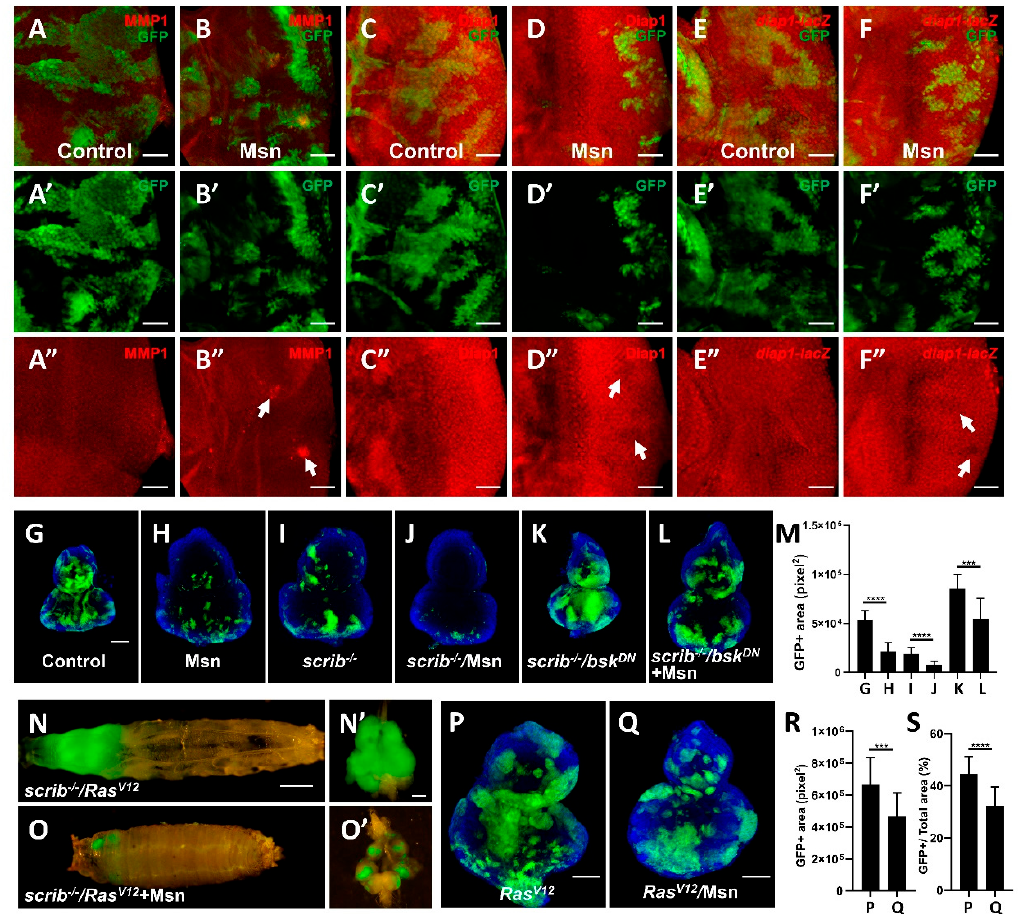
Figure 3. Msn positively regulates Hippo signaling. ( A – F, A’ – F’ and A” – F” ) Fluorescence micrographs of eye discs are shown. Compared with wild type ( A – A” , C – C” and E – E” ), Msn overexpression induces mild JNK activation ( B – B” ) and Hippo target gene downregulation ( D – D” and F – F” ). ( G – L ) Fluorescence micrographs of GFP-labeled clones of eye discs are shown. Msn overexpression decreases wild type clone size ( G and H ), scribble ( scrib) − / − clone size ( I and J ), and significantly impedes scrib − / − / bsk DN -induced clone overgrowth ( K and L ). ( M ) Quantification of GFP-positive area of indicated genotypes. ( N , O ) Msn overexpression suppresses Ras V12 / scrib − / − tumor growth. ( P – S ) Msn overexpression suppresses Ras V12 absolute and relative clone size ( P and Q ). Quantification of GFP-positive absolute ( R ) and relative area ( S ) of indicated genotypes. *** p < 0.001 (mean + S.D.); **** p < 0.0001 (mean + S.D.). Scale bars represent 50 µ m ( A – F ), 100 µ m ( G – L and P , Q ), 500 µ m ( N , O ), 200 µ m ( N ’, O